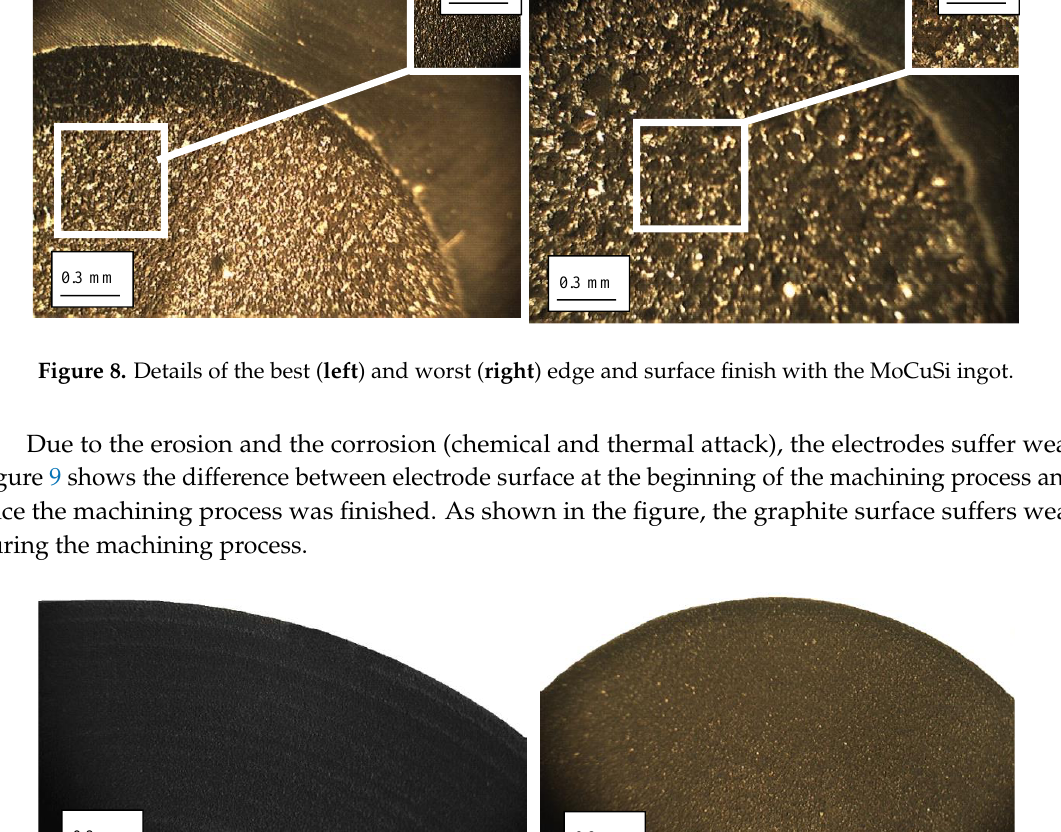
Figure 7. Details of the best ( left ) and worst ( right ) edge and surface finish with the MoCuSi ingot.